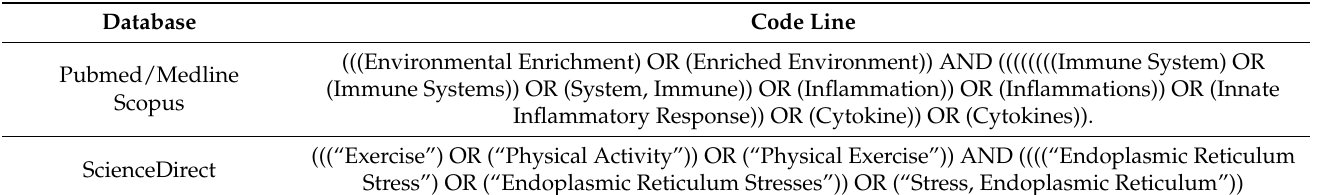
Table 1. Sample search strategy on the